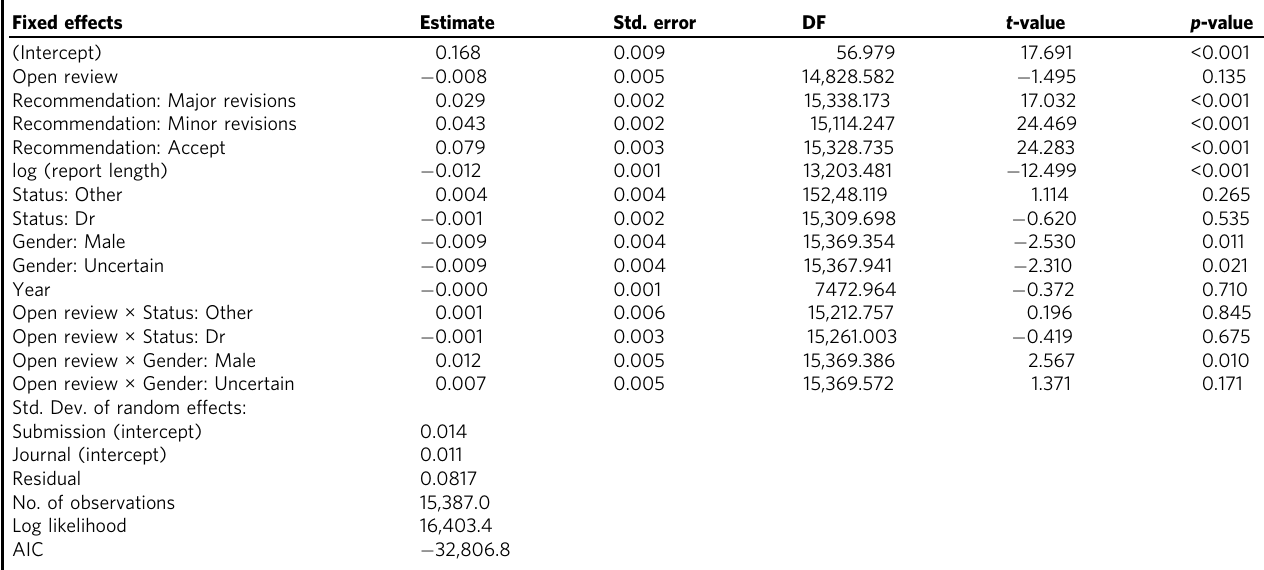
Table 4 Mixed-effects linear model on the polarity of review reports Fixed